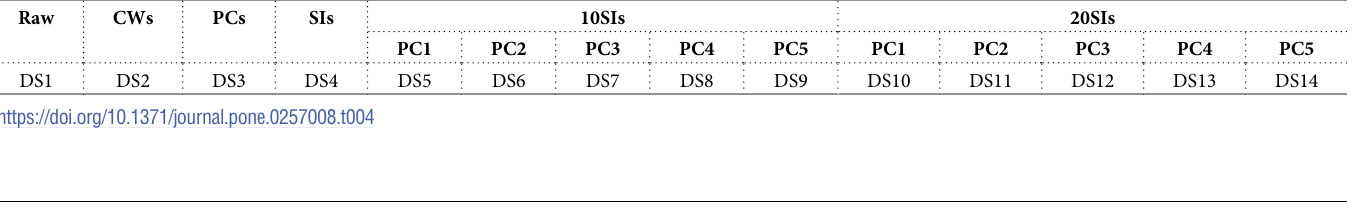
The classification accuracies of SVM and LS-SVM models for overall and individual class (class 0–4) with a total of 14 datasets, are illustrated and compared in Tables 6 and 7, respec- tively. The optimal parameters in the SVM and LS-SVM models were obtained using a grid- search procedure (Tables 6 and 7, respectively). Optimal parameters were used to achieve the optimal training model that predicted the testing samples. The ranges of γ and σ 2 were set within 10 − 2 –10 5 in LS-SVM. The parameters C and g in SVM were set in the range of 2 − 8 –2 8 . A total of 14 results were included in one class. The performances of different datasets varied from one another. Table 4. The 14 datasets used to build SVM and LS-SVM classification models of FLS.